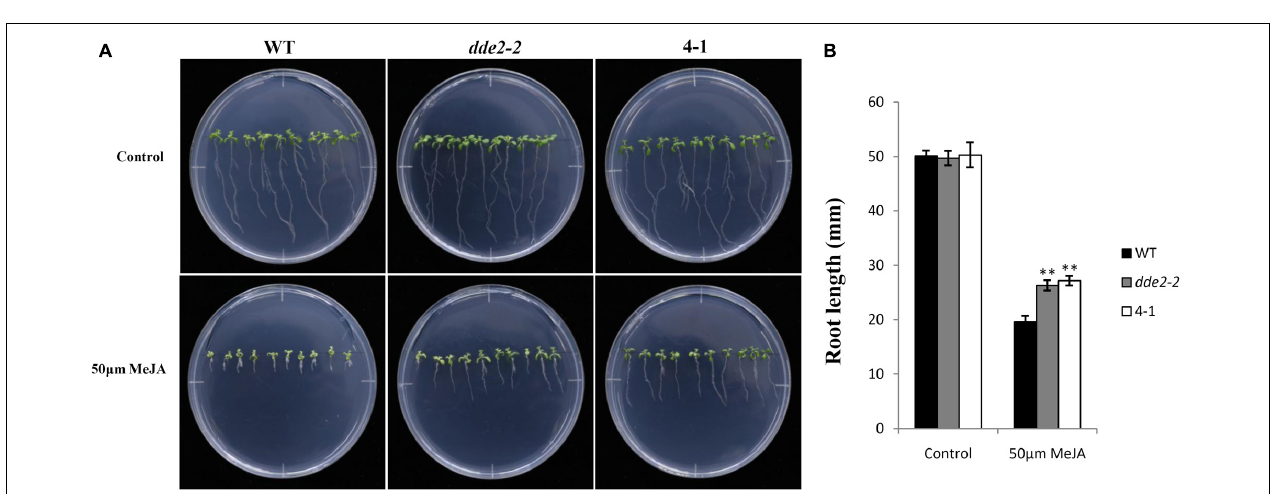
FIGURE 7 | JA concentration in wild-type, GrTCP11 -overexpressed lines (3-1, 4-1, 5-4, 8-3, and 10-4) and the JA-insensitive mutant dde2-2 . Three independent experiments were performed; error bars represent the standard deviation. Significant differences between the wild-type and other lines were calculated by Student’s t -test analysis ( ∗∗ P < 0.01).